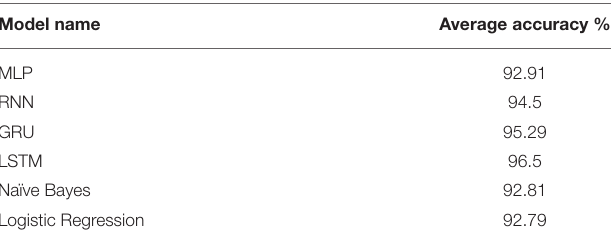
TABLE 3 | Training accuracy of models after